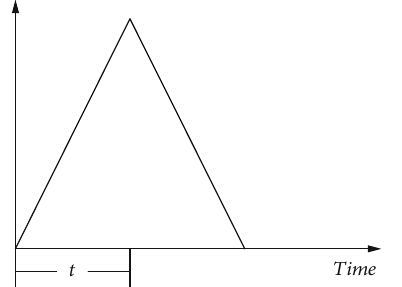
Figure 7: The simpli fi ed time history of water load ( t = 0 : 06 ~ 0.25s).